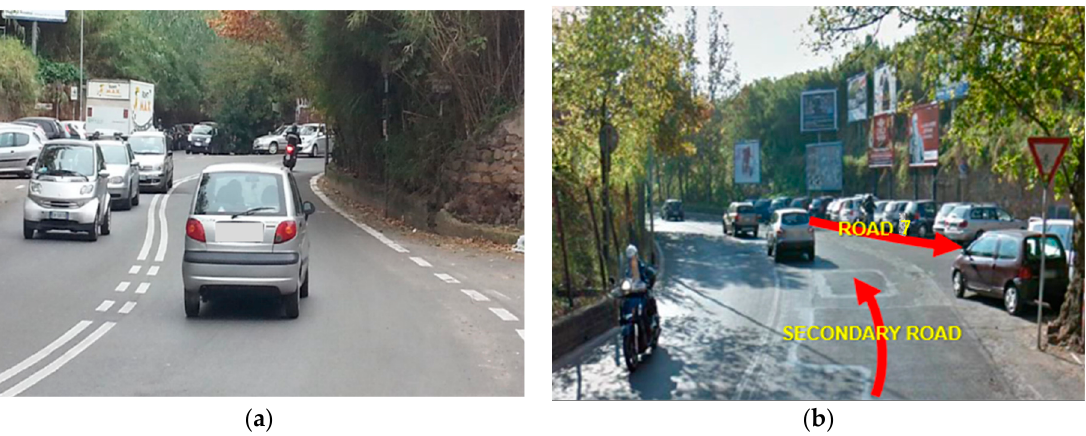
Figure 8a,b represent two surveyed conditions which belong to Section n.4.